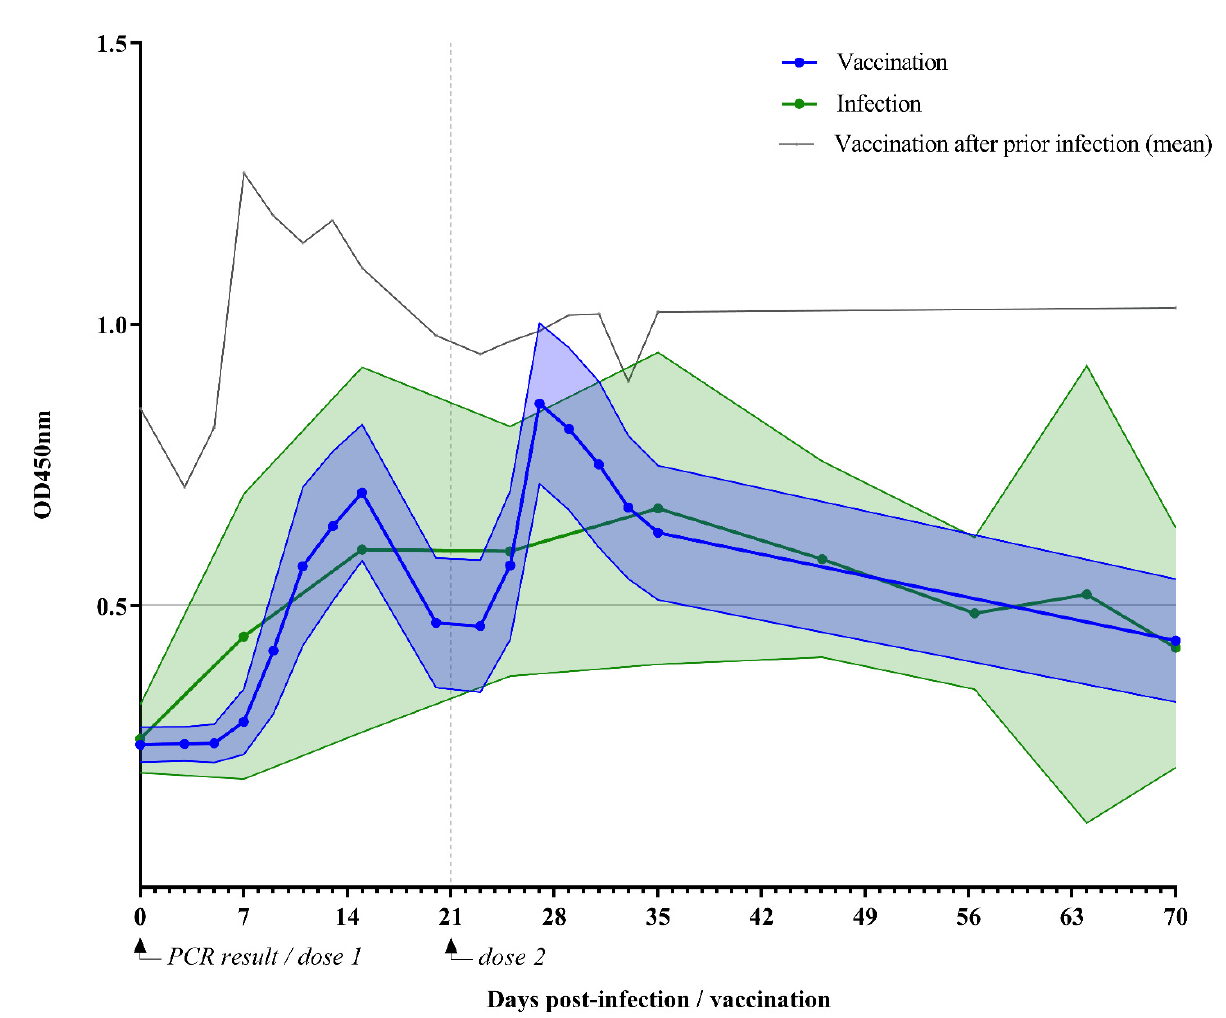
Figure 2. SARS-CoV-2-specific IgA levels following vaccination or infection. OD450 nm indicates optical density 450 nm. This figure shows specific IgA levels in human milk of lactating women over 70 days after vaccination with the mRNA-based COVID-19 vaccine BNT162b2 ( n = 26) or a naturally acquired SARS-CoV-2 infection ( n = 18). The solid dotted lines indicate mean IgA level in human milk following vaccination (blue) or infection (green); filled area between error lines indicates 95% confidence interval. The grey solid line indicates the mean IgA level in human milk following vaccination after prior infection ( n = 2). The horizontal grey line at 0.502 represents the cutoff value for the detection limit of IgA in human milk. Table 4. Area under IgA titer curves over one month and 70 days.